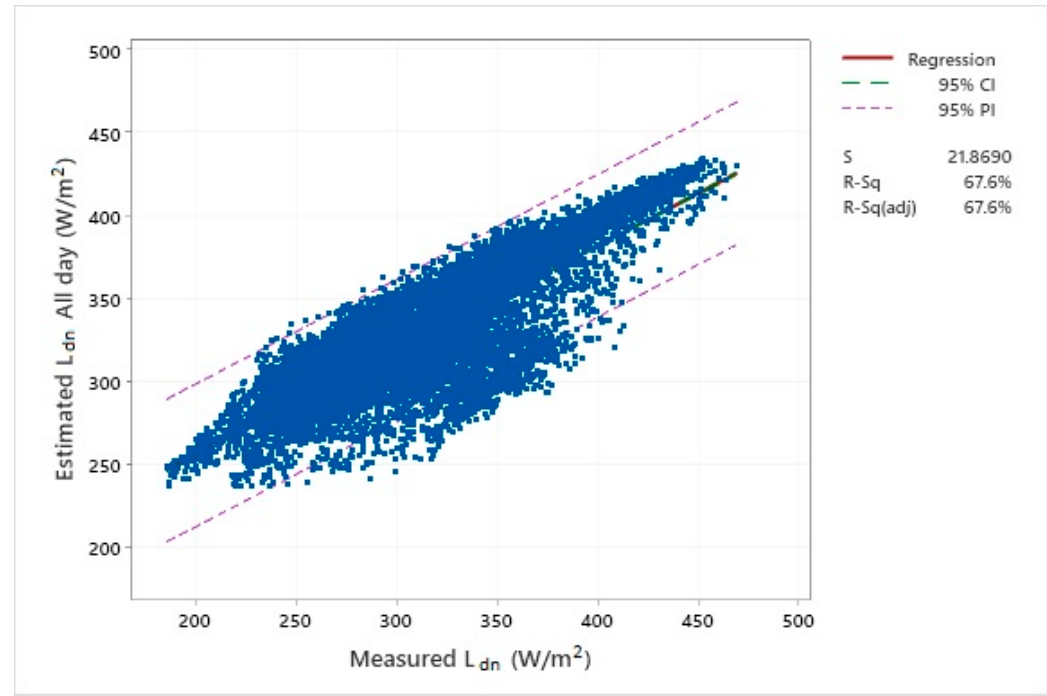
Figure 17. Comparison of estimated and measured L dn for the all day time interval for the data set of the period 2016–2017.